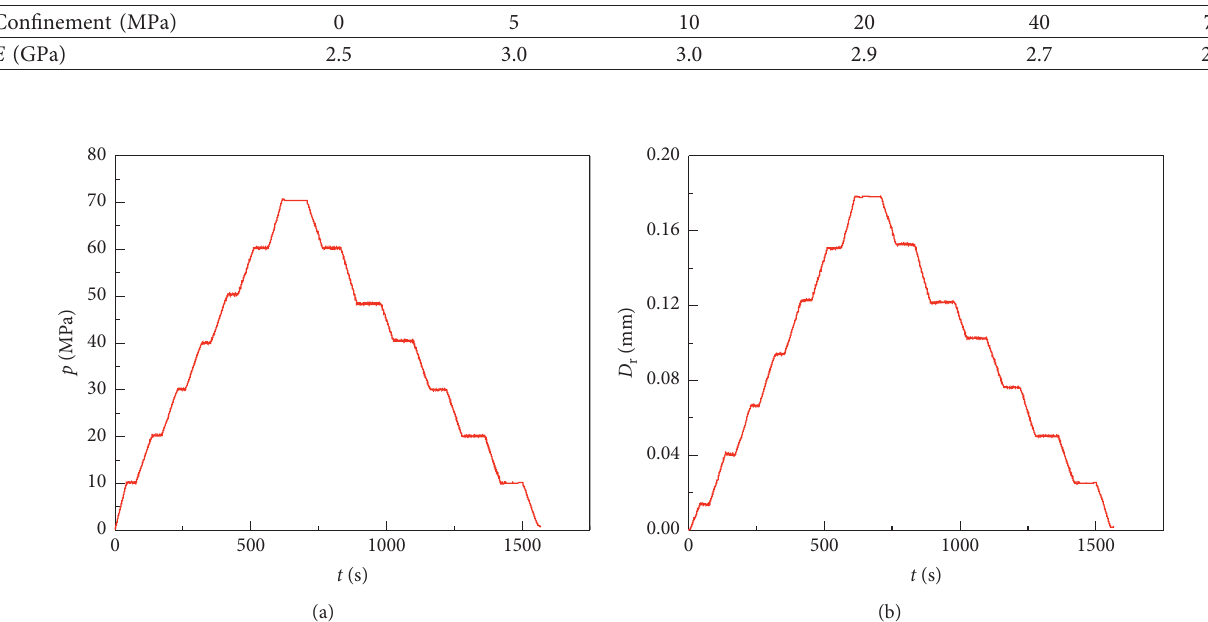
Figure 6: The relationships between (a) p and t and (b) D